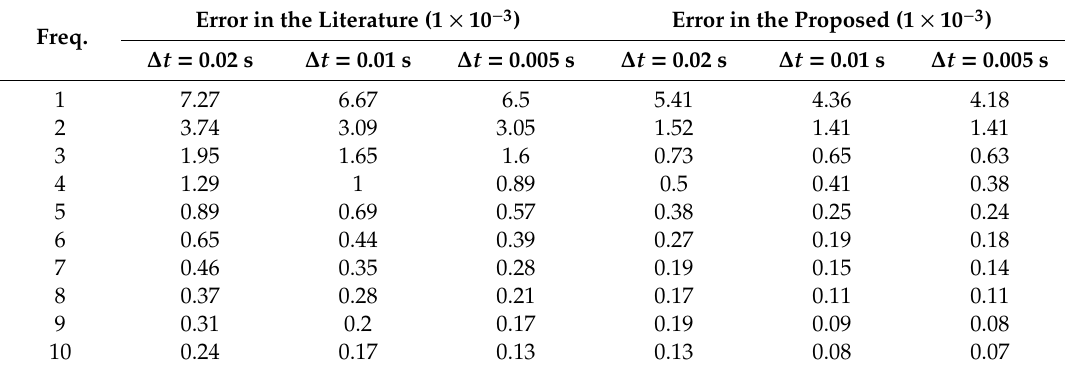
Table 4. Root-mean-square error (RMSE) between the proposed and the literature methods [22].